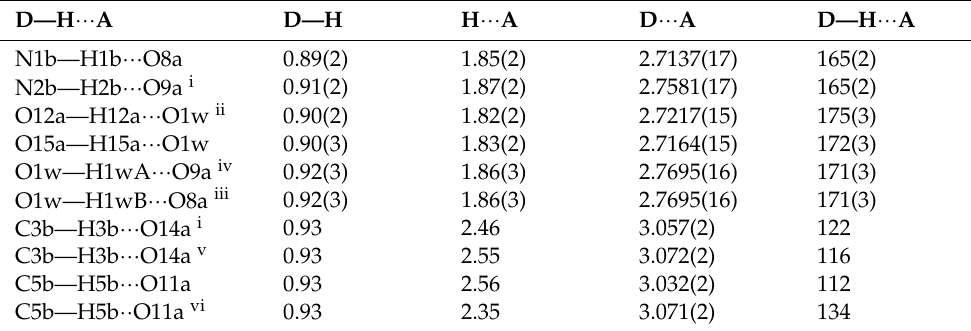
Figure 3. Hydrogen bonds O1w—H1wA···O9a iv and O1w—H1wB ···O8a iii linking types into layers parallel to the bc plane. The symmetry codes are explained in Table 1. Table 1. Hydrogen-bond geometry (Å, °) for PyrHem×H 2 O.